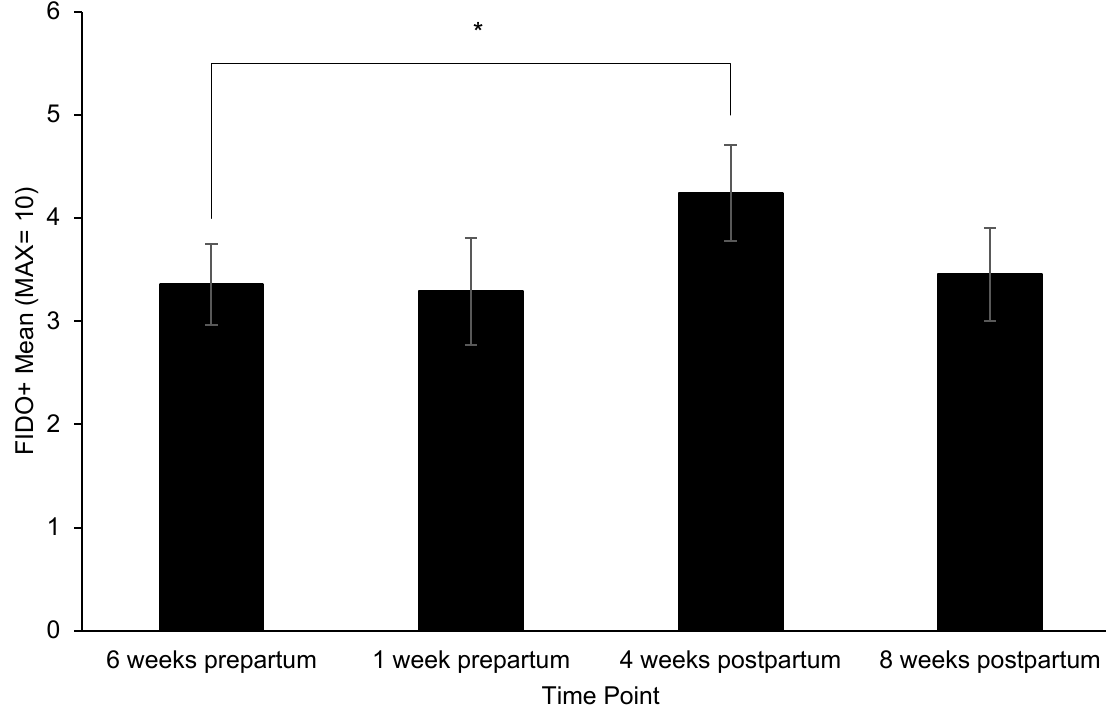
Figure 2. Change in Field Instantaneous Dog Observation Tool + (FIDO+) response across time points. Sample sizes for each time point were n = 59, n = 38, n = 57, and n = 55, respectively. Error bars represent SE. * indicates p ≤ 0.05.